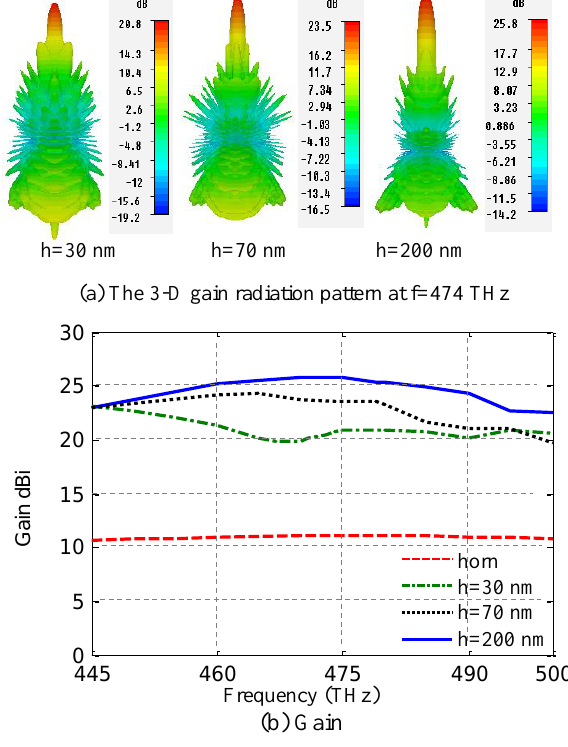
Figure 10 (a) The 3-D gain radiation pattern at f =474 THz, (b) The gain variation versus frequency for a 21 × 21 NDRA